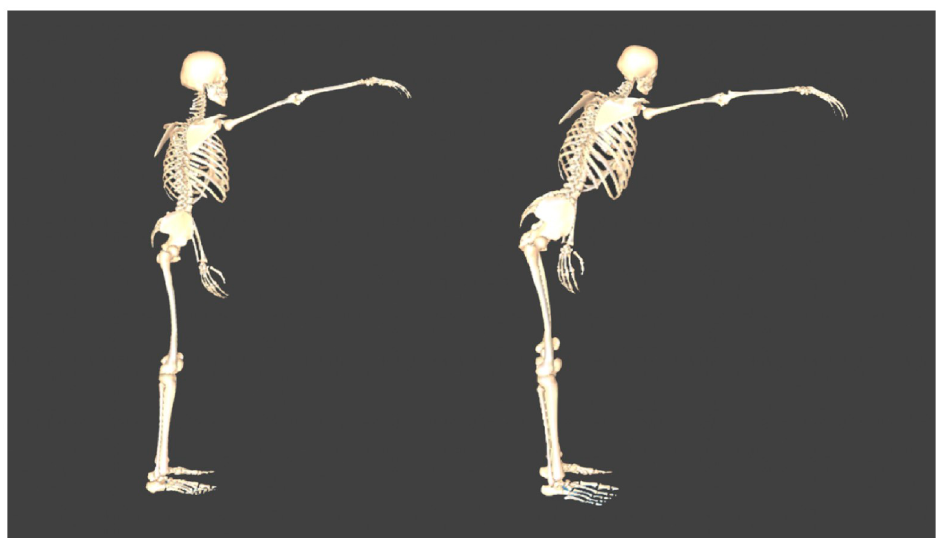
Fig 4. Typical Functional Reach Test patterns. Left (Cluster 1): use of the small hip strategy. Right (Cluster 2): use of the large hip strategy.